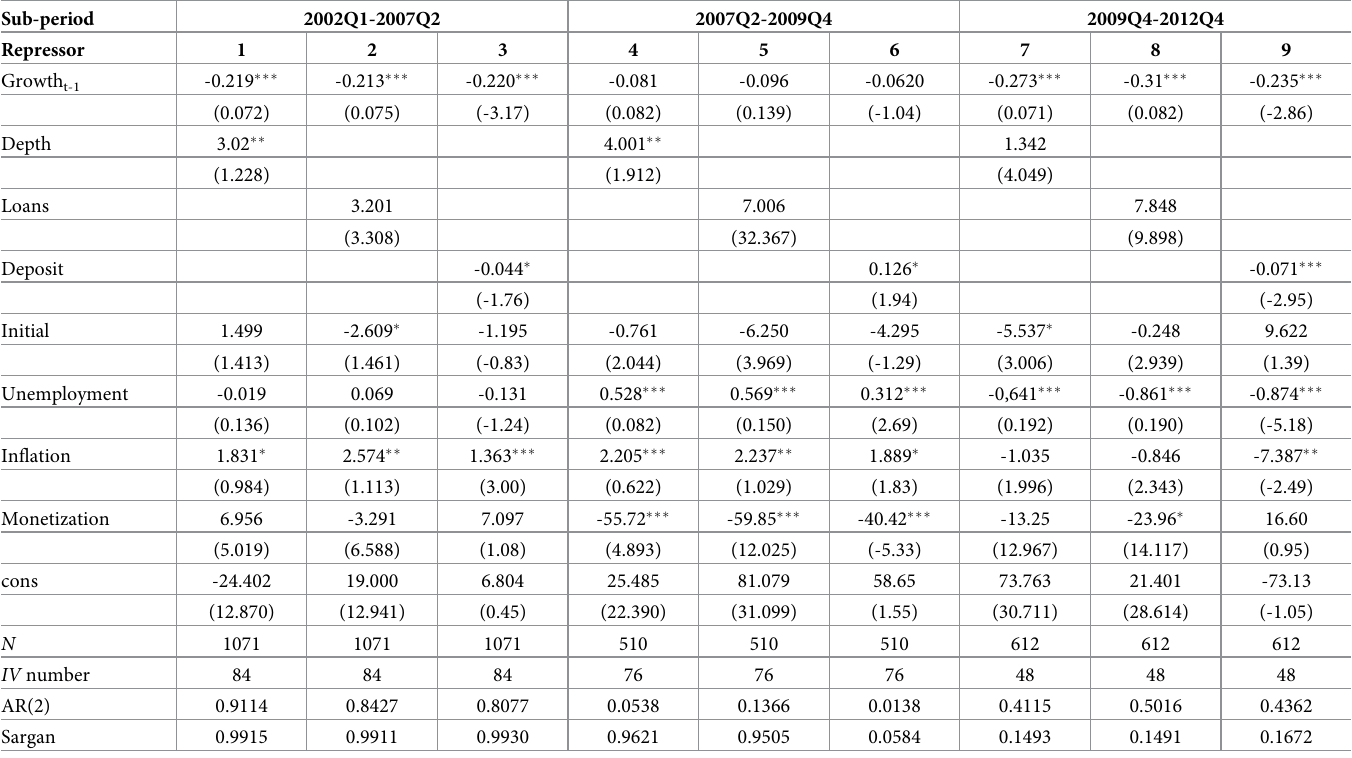
Table 5. Sub-period system GMM estimation (without